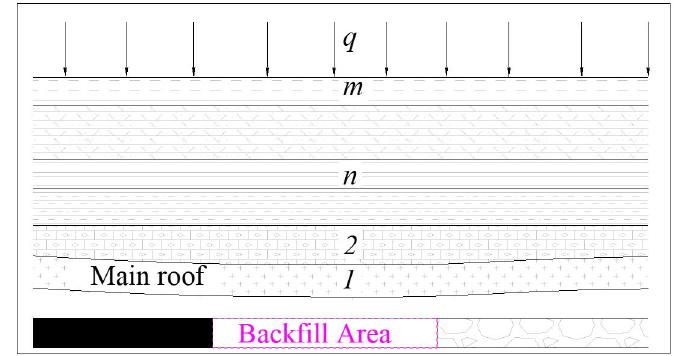
Figure 8. Solving model of composite beam roof